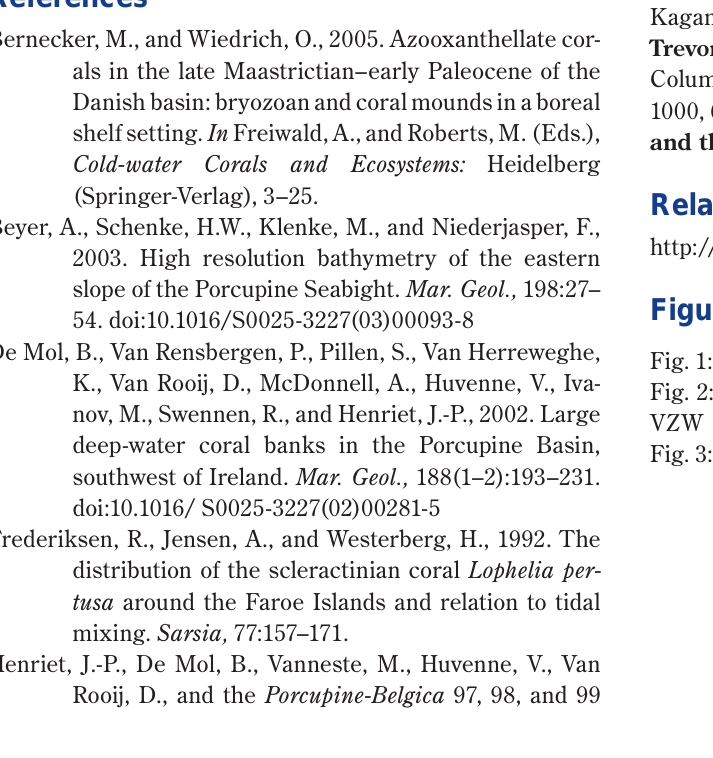
Fig. 1: 3-D map from Beyer et al., 2003. Fig. 2: Photo by E. Van der Meersche ©MINERAL COLOR VZW Fig. 3: Mound Seismic from DeMol et al.,